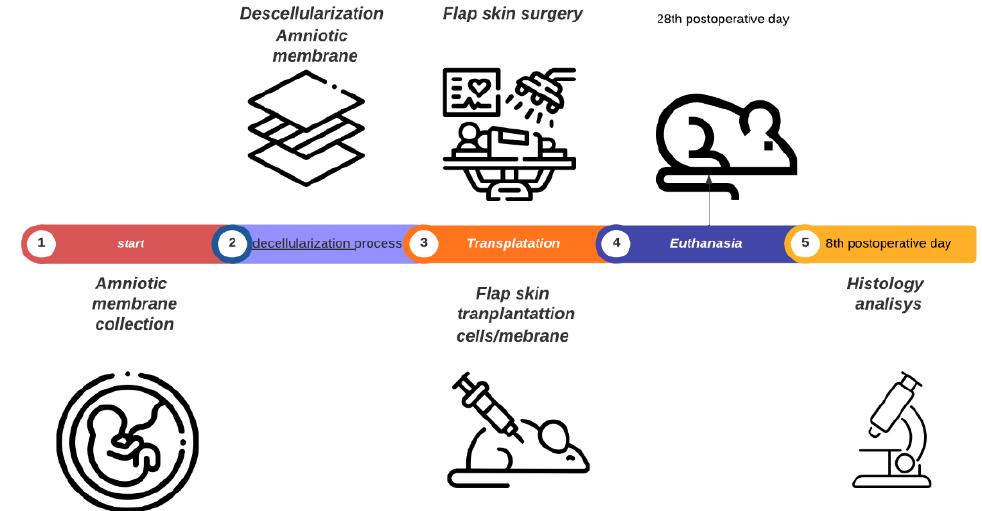
Figure 1. Experimental design: amniotic membrane collection, stem cell isolation, process membrane decellularization, flap skin surgery, implant, euthanasia, and histopathological analysis.